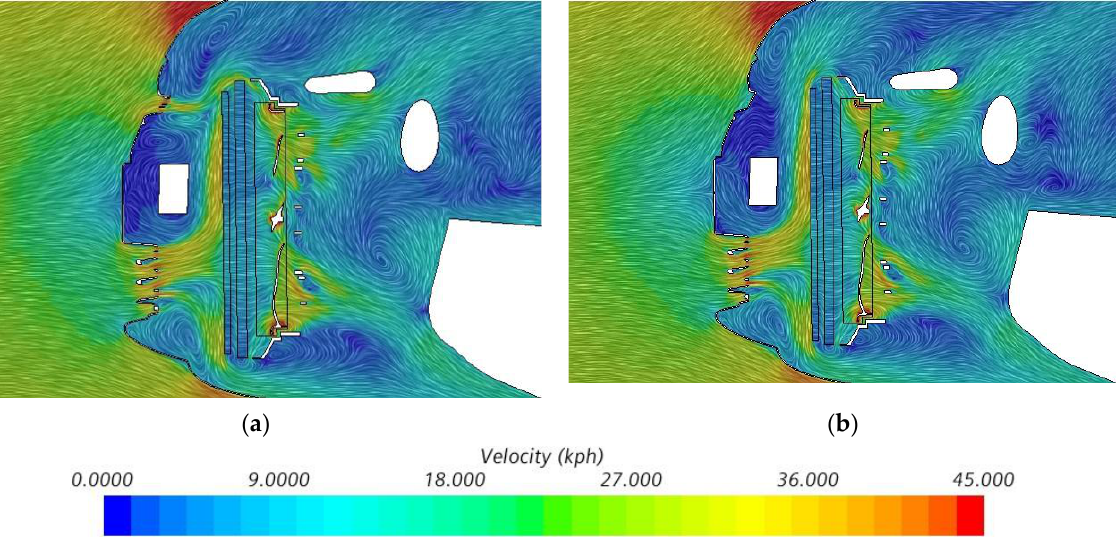
Figure 12. Comparisons of y = − 0.17 m section velocity fields between scheme 1 and original vehicle: ( a ) original vehicle; ( b ) scheme 2.